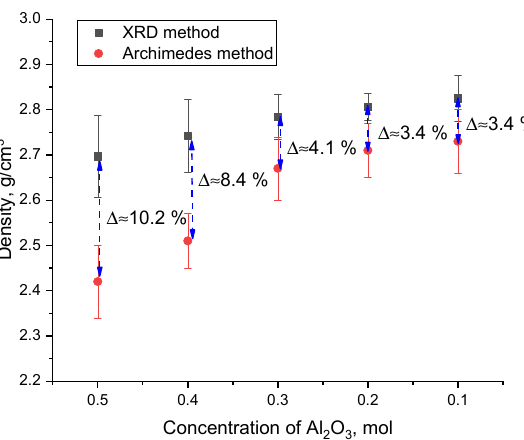
Figure 10. SEM images of synthesized ceramics in the Backscattered electron image mode: ( a ) 0.5Al 2 O 3 –0.5Si 3 N 4 ; ( b ) 0.4Al 2 O 3 –0.6Si 3 N 4 ; ( c ) 0.3Al 2 O 3 –0.7Si 3 N 4 ; ( d ) 0.2Al 2 O 3 –0.8Si 3 N 4 ; ( e ) 0.1Al 2 O 3 –0.9Si 3 N 4 .